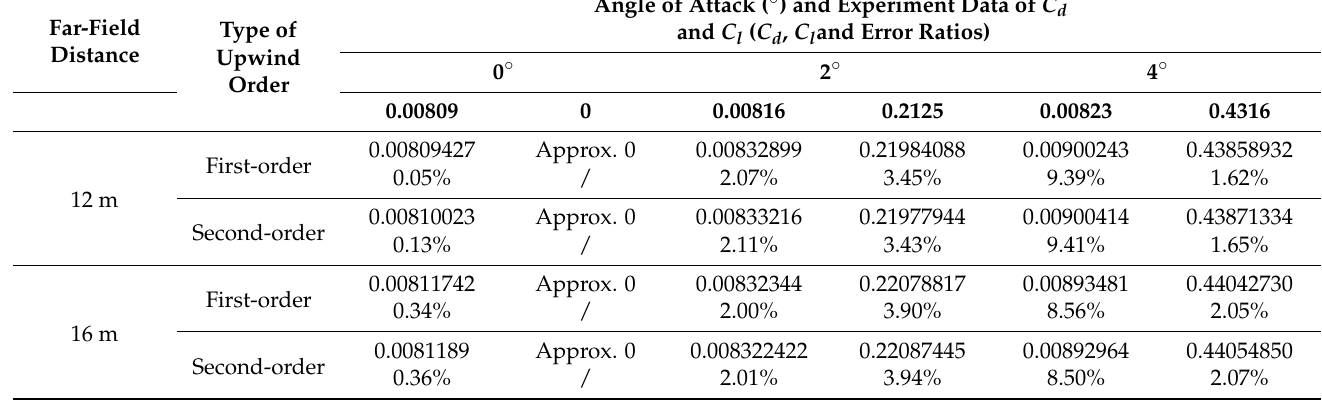
Table 3. Comparative data of the modified turbulent viscosity of Spalart–Allmaras applying first- order upwind and second-order upwind.